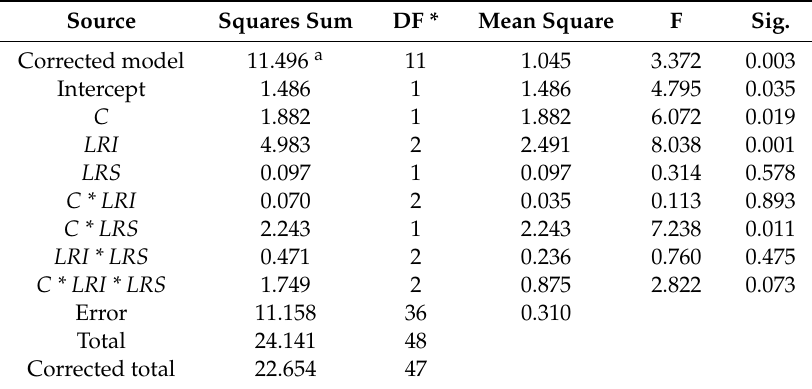
Table 5. Mg-Al-Mg test. Last ANOVA iteration for Ln Ra